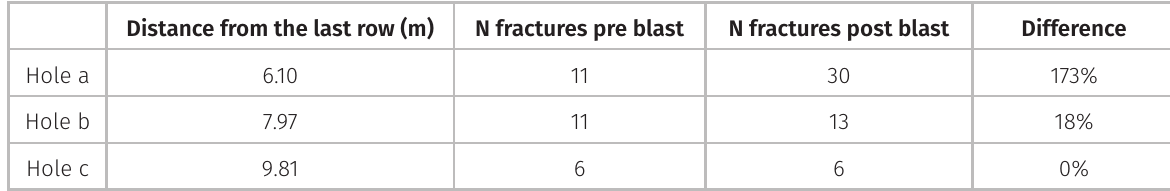
Figure 8. Images from the inspected holes of blast test 1. A has been made in the upper third of hole a, while b and c show the reduction of fracturing of holes b and c, both represented in Figure 3. Table VIII. Fracturing intensity pre and post blast test